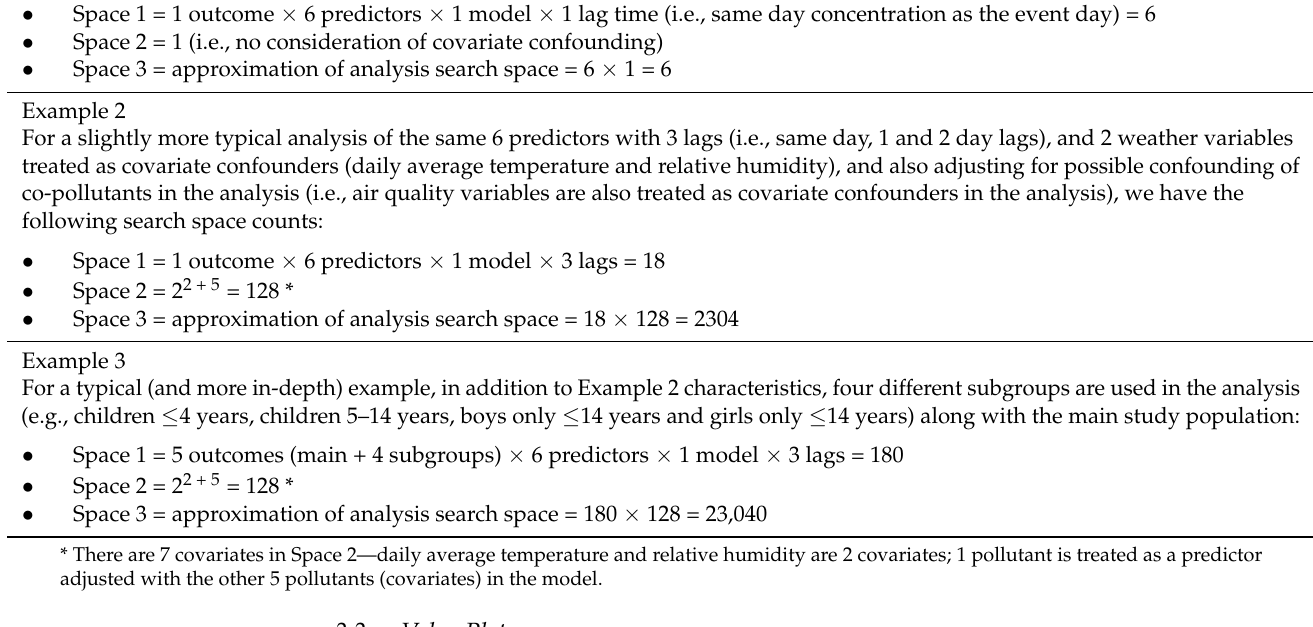
Table 2. Three examples of search space analysis of a hypothetical observational study of ambient air quality versus hospitalization due to asthma